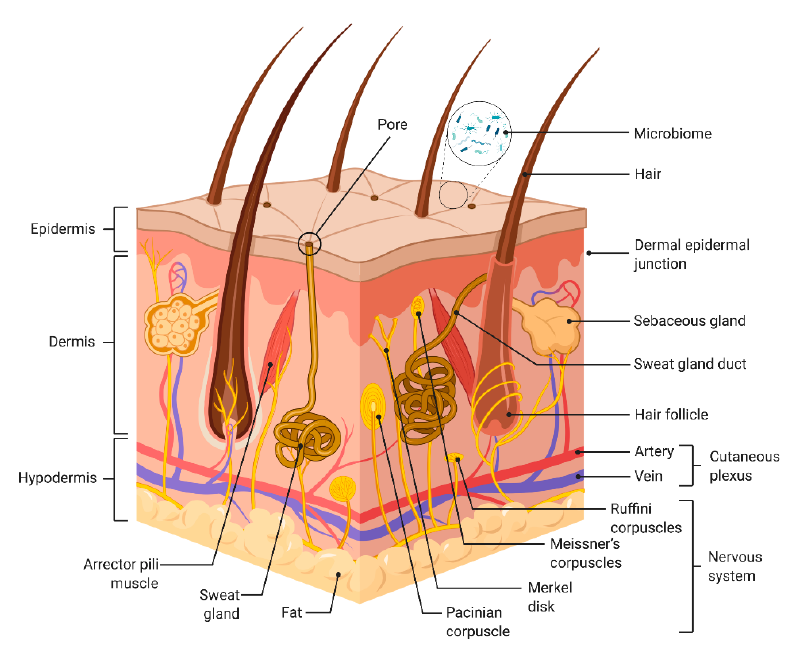
Figure 1. Schematic representation of the different skin layers. Adapted from ‘Anatomy of the skin’, by BioRender.com (2022). Retrieved from https://app.biorender.com/biorender-templates, accessed on 9 June 2022.